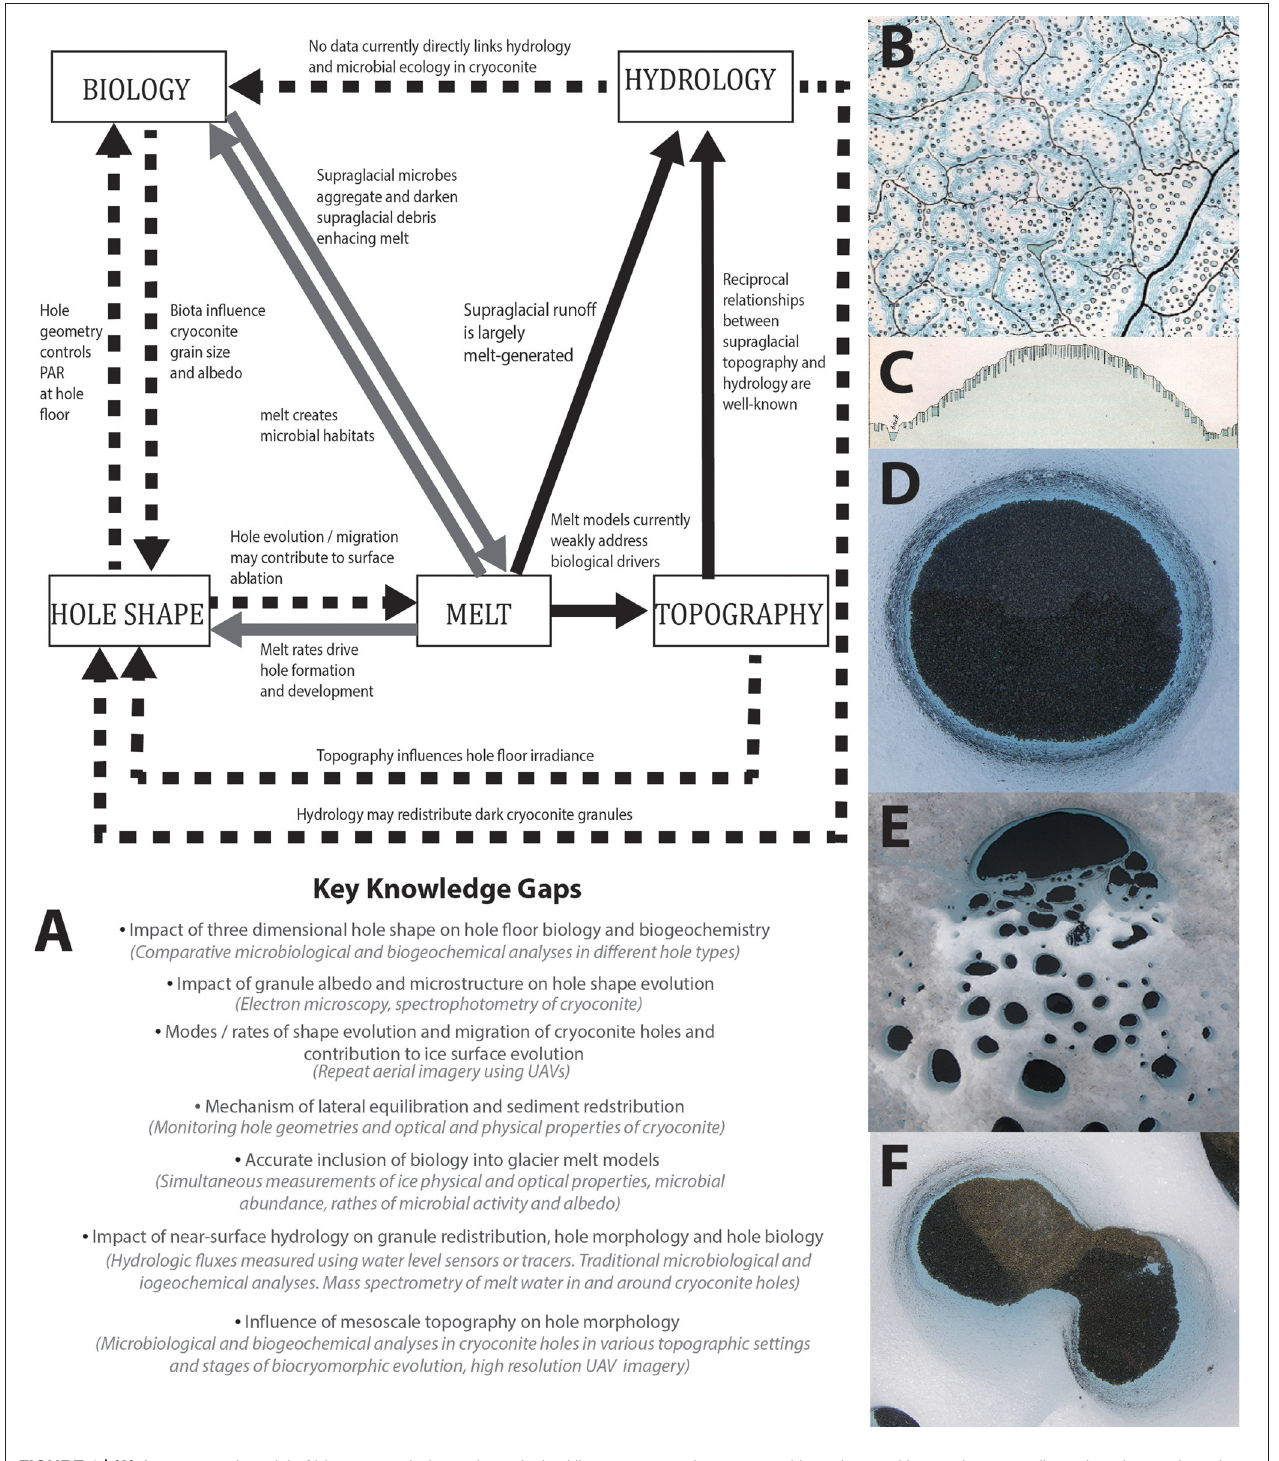
FIGURE 1 | (A) A conceptual model of biocryomorphology where dashed lines represent the most weakly understood interactions, gray lines show interactions that are understood conceptually but where much more data is required and solid lines represent well-understood processes. Bullet points highlight key knowledge gaps and suggestions for investigation methods are provided in brackets. (B) Extract from Nordenskiöld’s (1885) field sketch showing cryoconite holes in plan view. (C) Extract from Nordenskiöld’s (1885) field sketches showing cryoconite holes in profile view. (D–F) Photographs showing diverse cryoconite hole shapes in plan view.